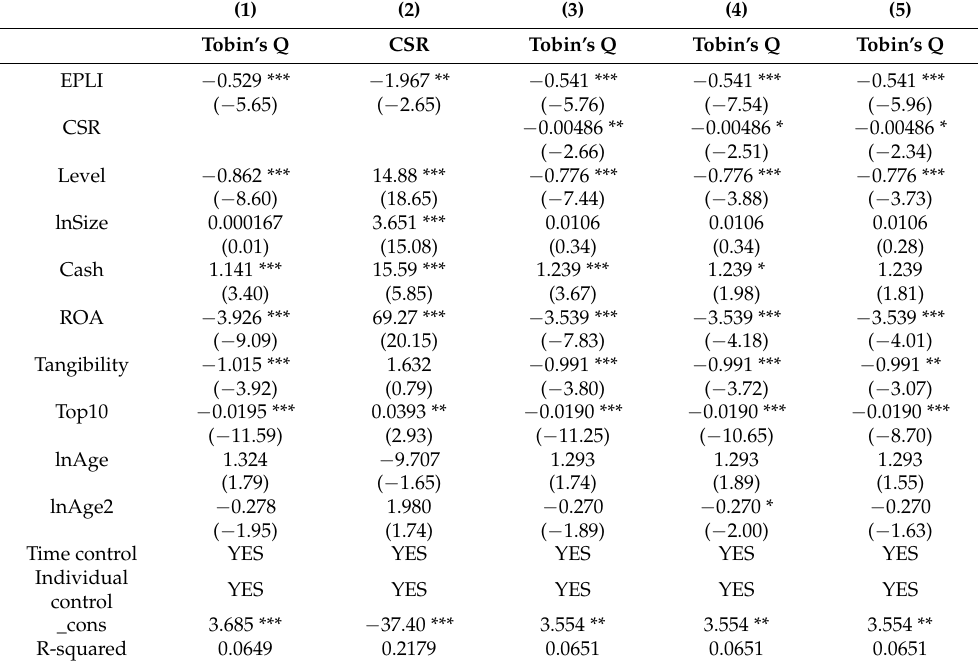
Table 7. The mediating effect of CSR on the impact of EPLI on corporate